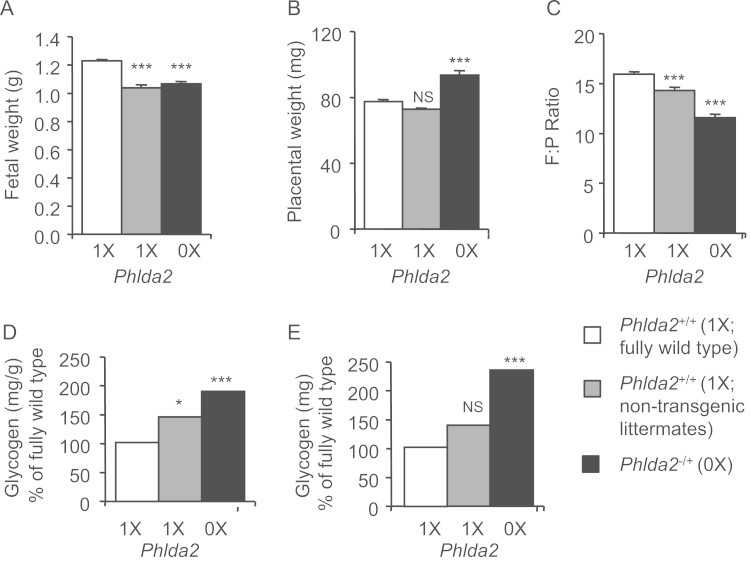
Phlda2 deficiency drives global foetal growth restriction. A. Weights of non-transgenic and Phlda2−/+(0X) fetuses compared with true 129 wild type values (wild type fetuses carried by wild type females). Both genotypes weigh less than fully wild type fetuses. B. Weights of non-transgenic and Phlda2−/+(0X) placenta compared with true 129 wild type values. Phlda2−/+(129)(0X) placenta weigh considerably more than fully wild type placenta. C. Comparison of F:P ratios between non-transgenic, Phlda2−/+(129)(0X) and true 129 wild type. Both the non-transgenic and the Phlda2−/+ratios are significantly different to the fully wild type ratio. D. Direct biochemical determination of glycogen in Phlda2+/+ and Phlda2−/+(0X) placenta at E18.5 as a percentage of true 129 wild type values expressed as total amount (mg) and as a proportion of placental weight (mg/g placenta). Phlda2−/+(0X) placenta and the non-transgenic placenta both contain significantly more glycogen than fully wild type placenta on the 129 genetic background when placental weights are taken into account. Numbers of samples given in Supplemental Table S8. Error bars represent SEM. Statistical significance calculated using one way ANOVA with Bonferroni correction for multiple comparisons: NSP>0.05, *P<0.05, **P<0.01, and ***P<0.005.